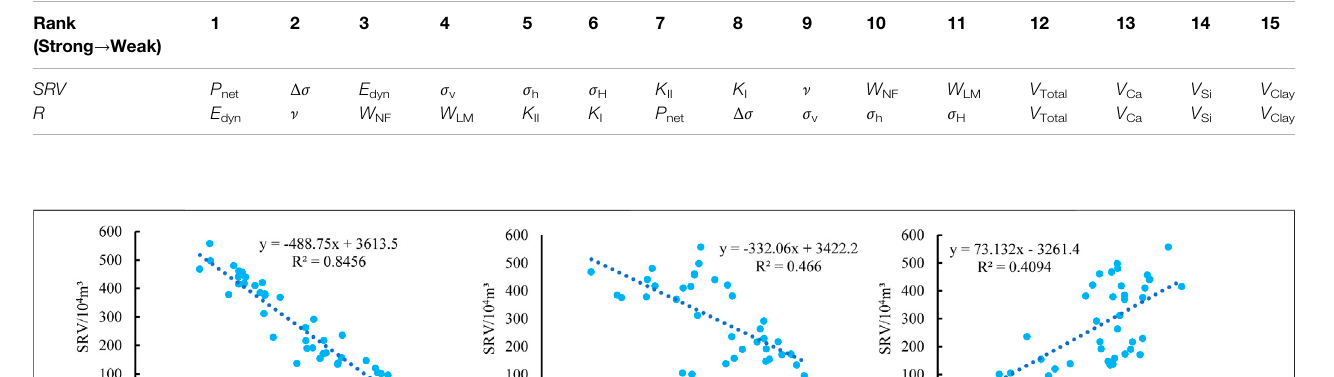
TABLE 2 | Correlation ranking of the in fl uencing factors to microseismic monitoring targets.